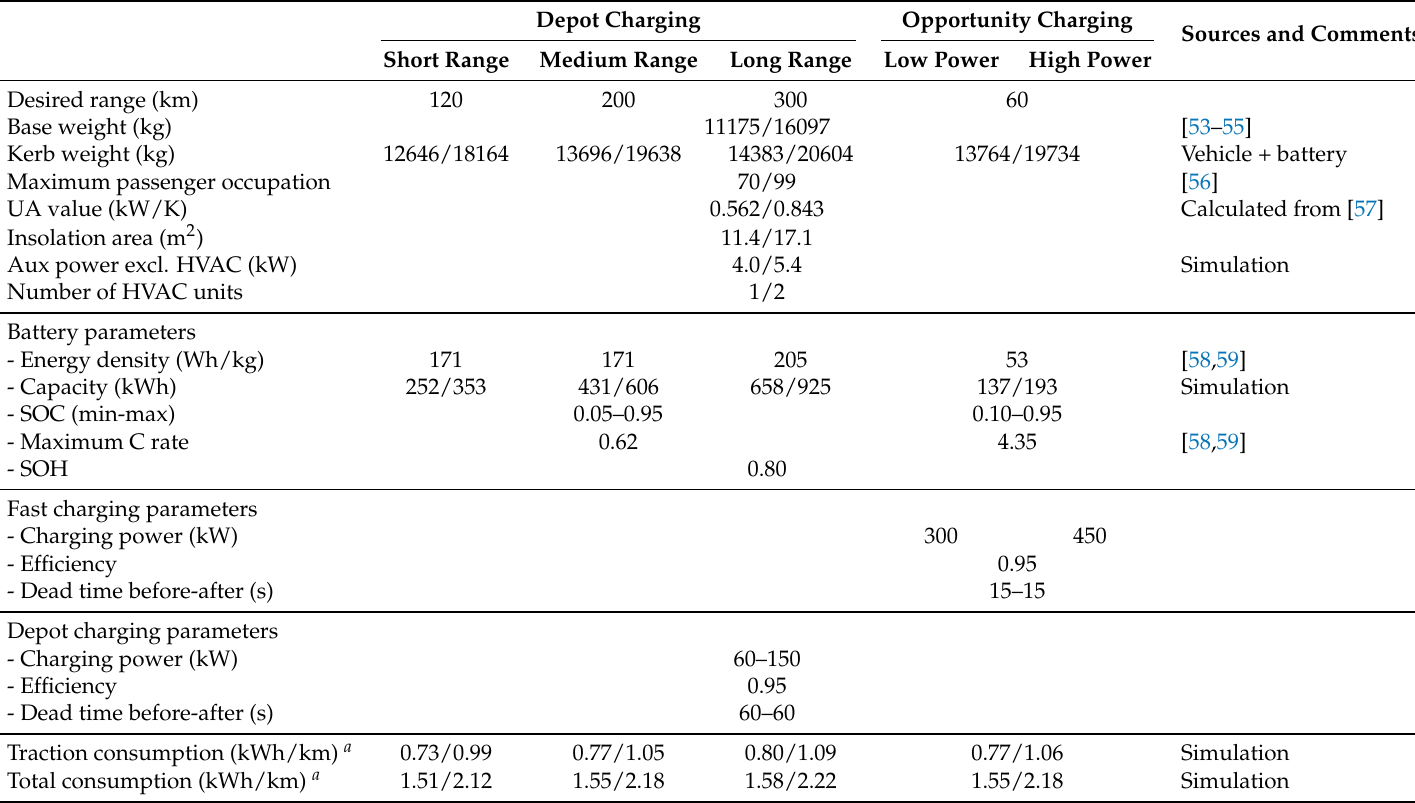
Table 5. Vehicle parameters used for schedule simulation. Values of the form X/Y denote standard and articulated buses,